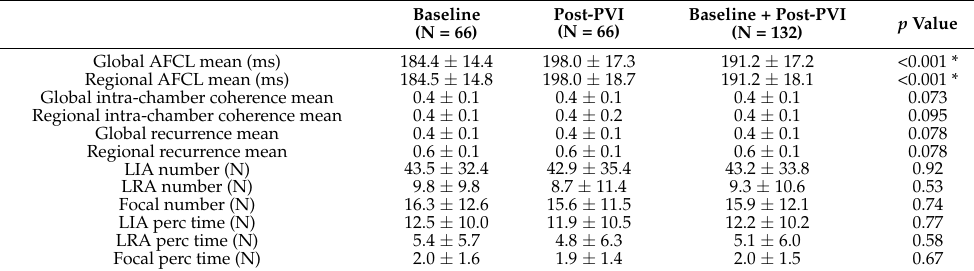
Table 2. Charge density map data pre- and post-pulmonary vein isolation.